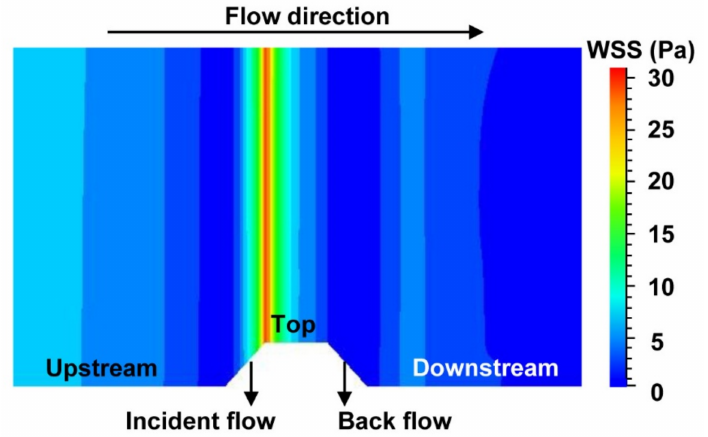
Figure 14. The contour of WSS at the WRH wall at the main flow velocity of 2.3 m/s.